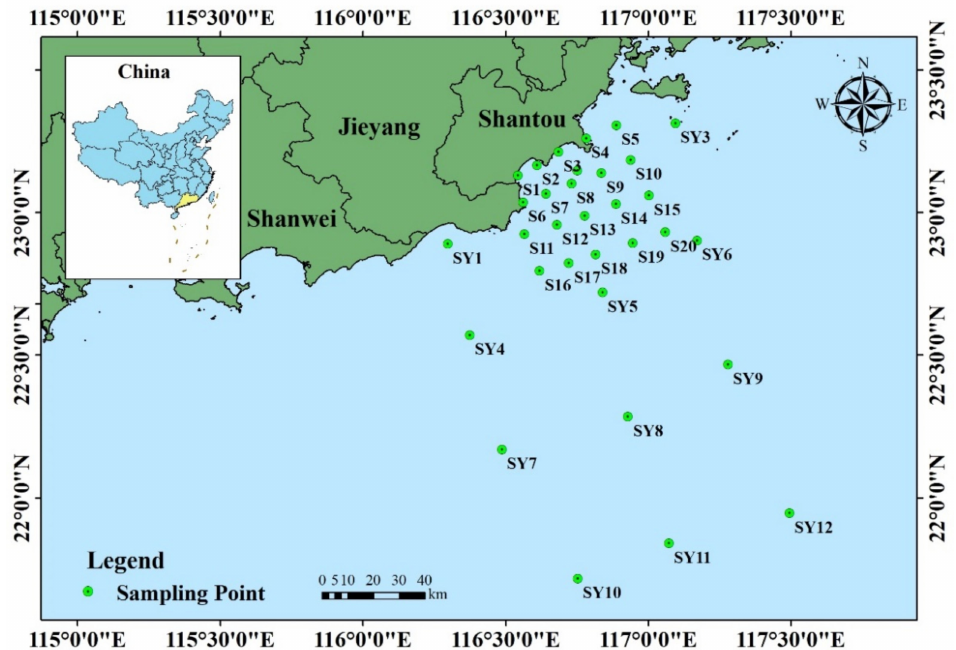
Figure 1. Study area and sampling